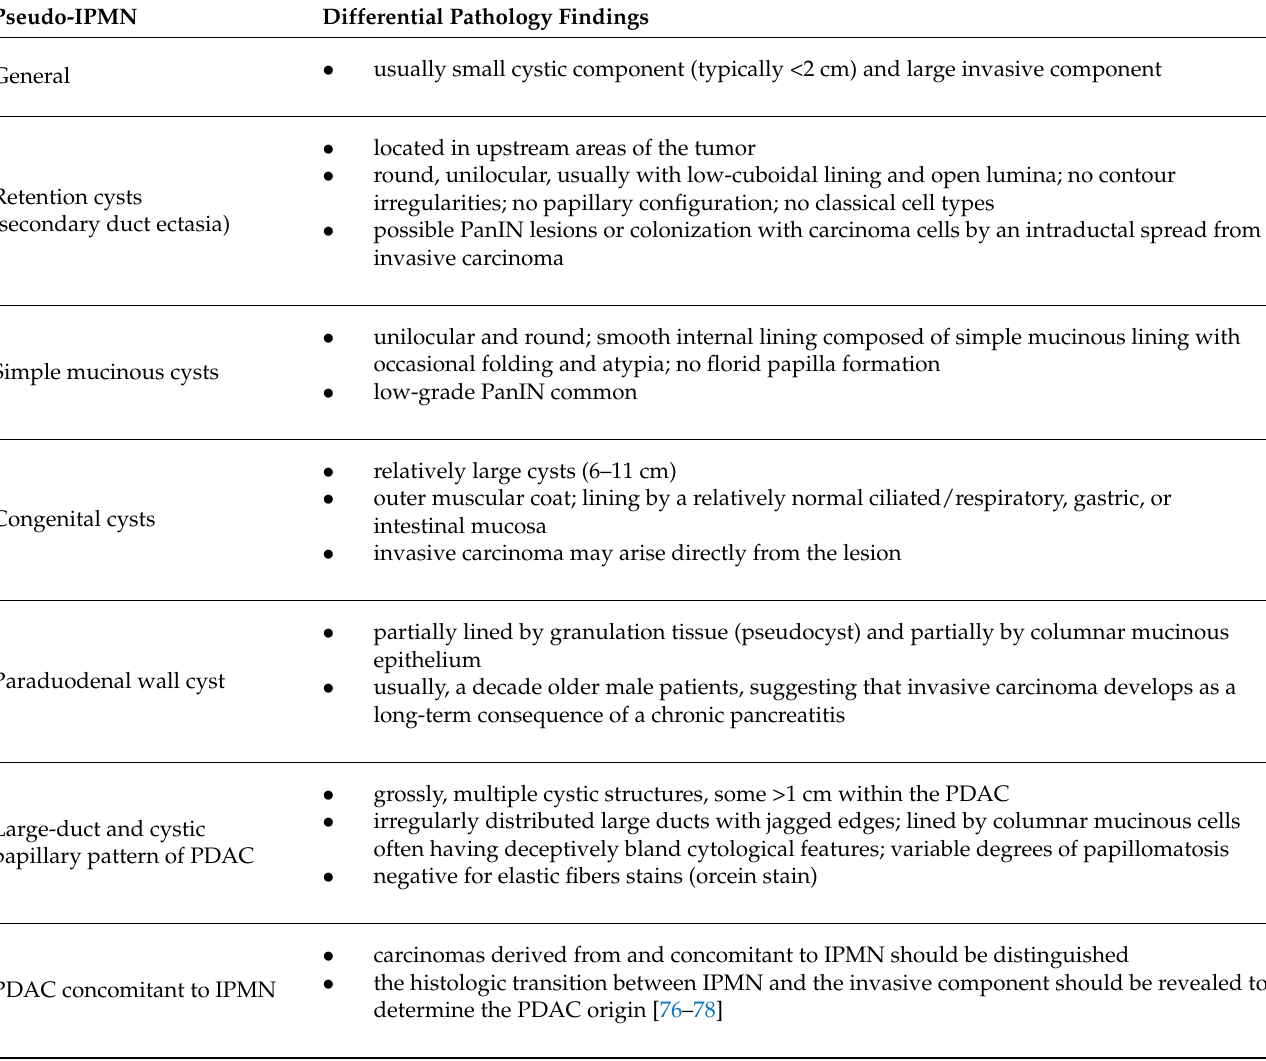
Table 1. The differential diagnosis for IPMN-associated carcinoma. PanIN, pancreatic intraepithe- lial neoplasia; PDAC, pancreatic ductal adenocarcinoma; IPMN, intraductal papillary mucinous